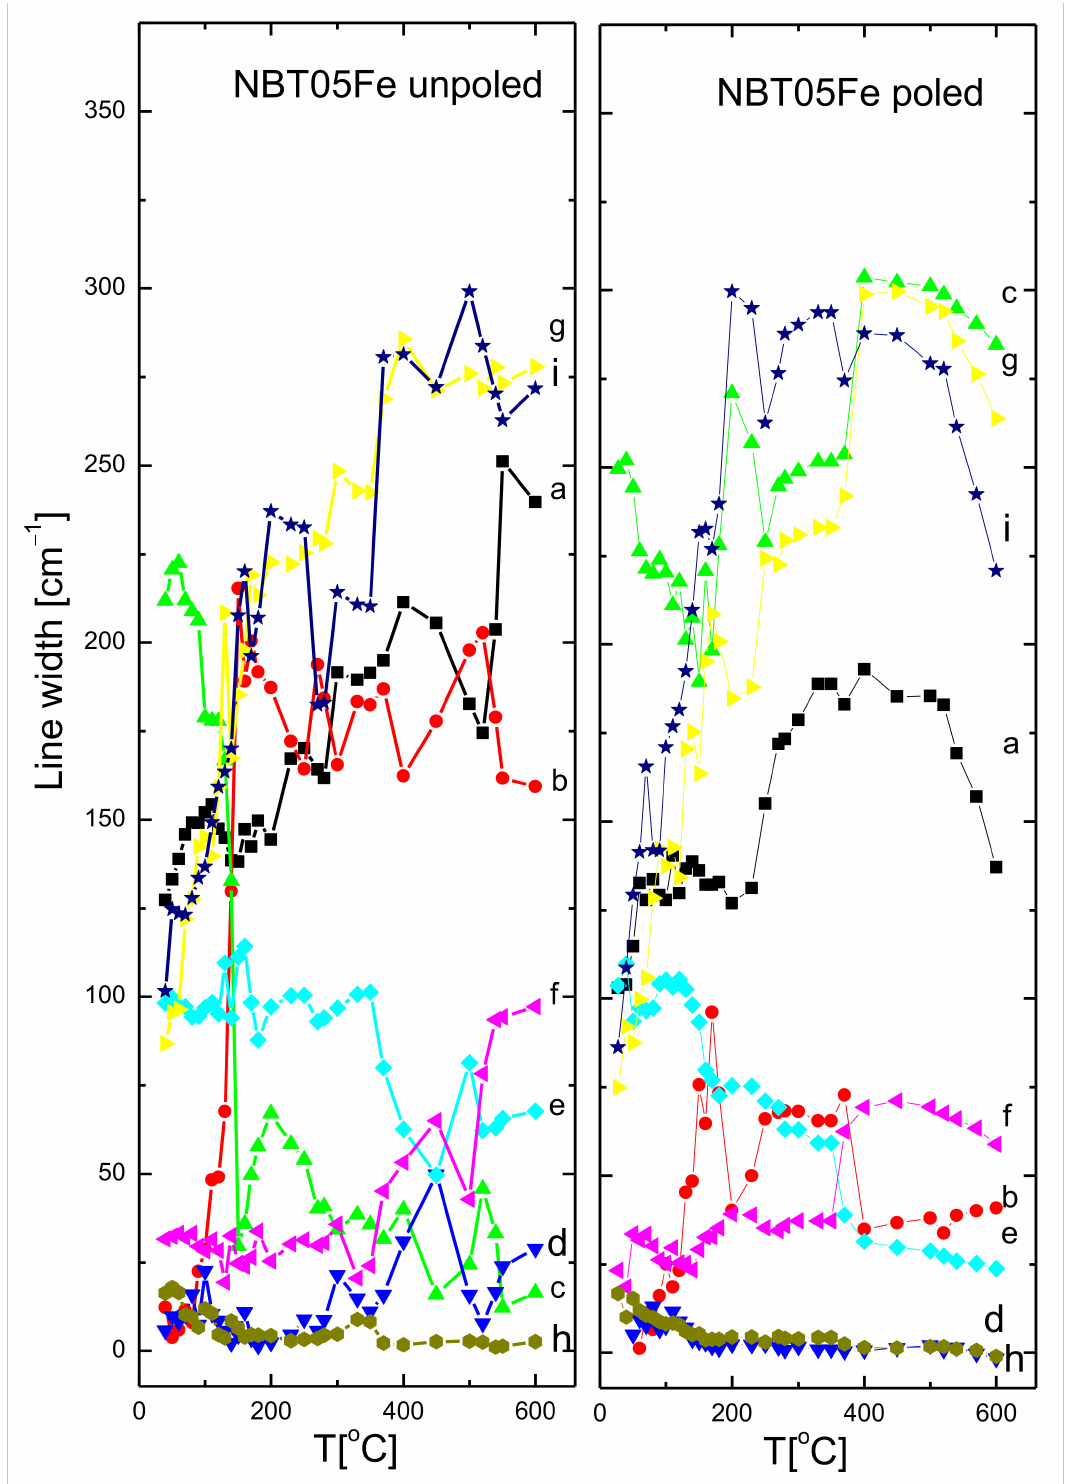
Figure 10. The temperature evolution of FWHM of unpoled and poled NBT05Fe. The a, b, c, d, e, f, g, h and i are mode